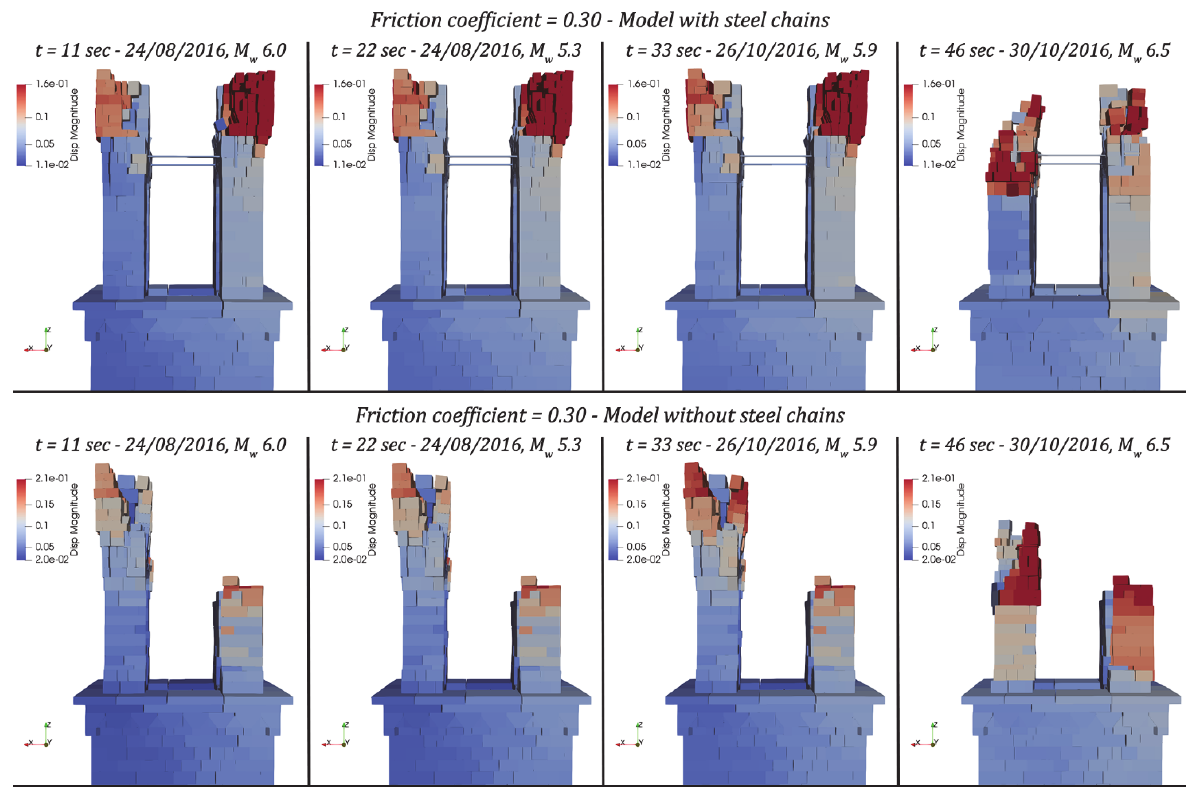
Figure 13: Numerical cumulative damages of the civic clock tower of Amatrice (Rieti, Italy) under the four main shocks recorded in the village during the Central Italy seismic sequence of 2016 for both configurations, with and without the steel chains, and with the friction coefficient equal to 0.30 in the bell cell and 0.50 in the other